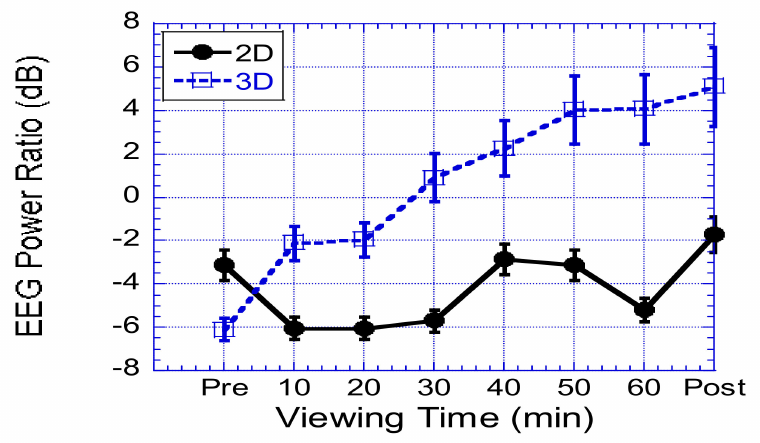
Figure 5. Effect of viewing time by display type on α / β power